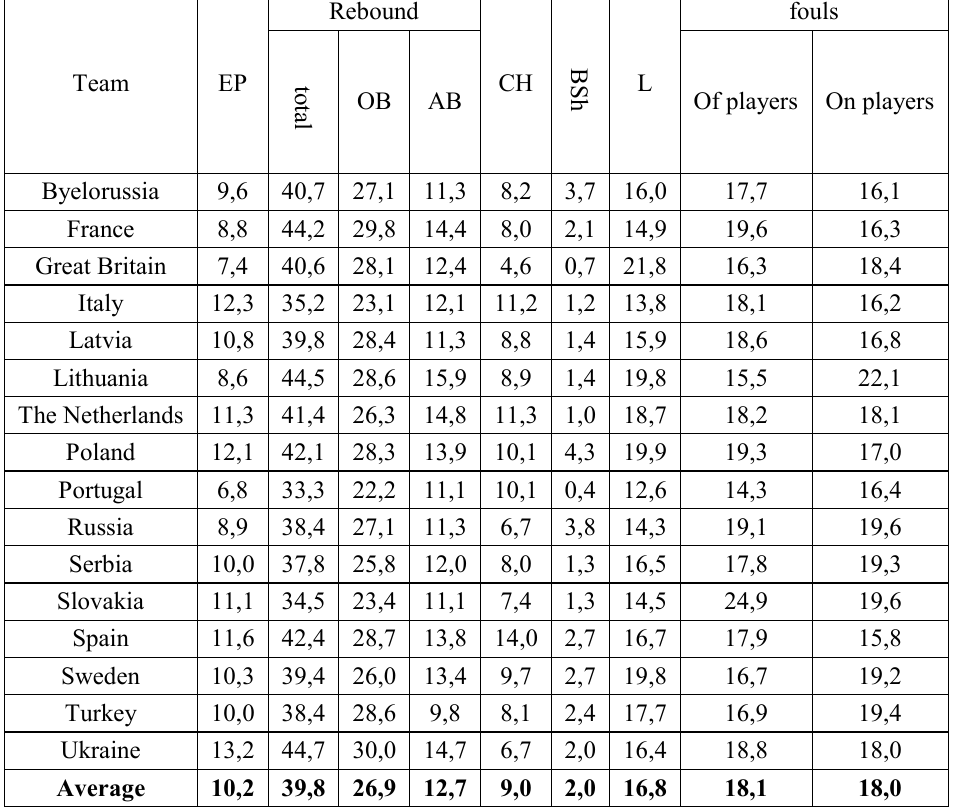
Game effectiveness indicators of women teams at European